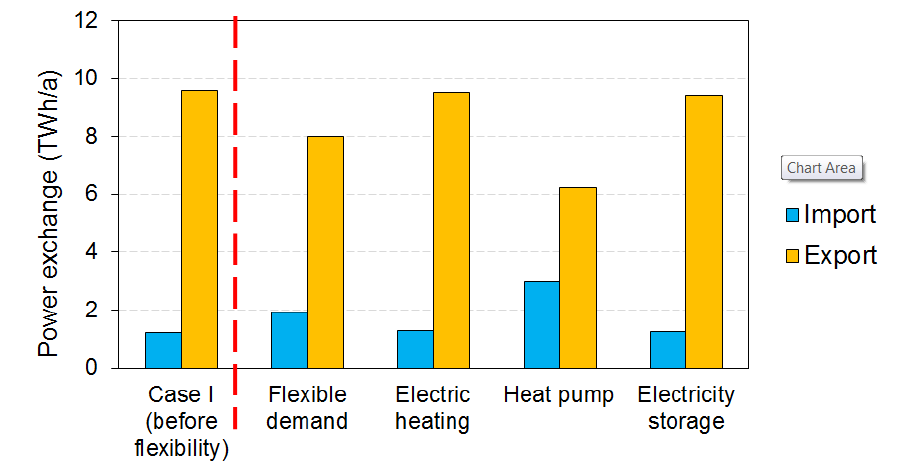
Figure 16. Effect of 300 MW e flexibility on power exchange between Finland and the external electricity market, compared with Case I.